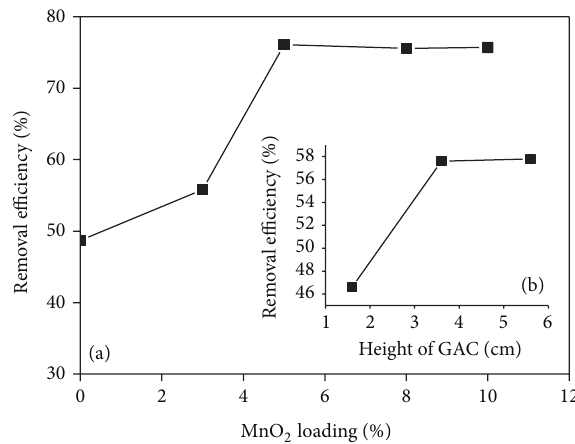
Figure 2: Photogenerated O 3 concentration as a function of inlet toluene concentration.